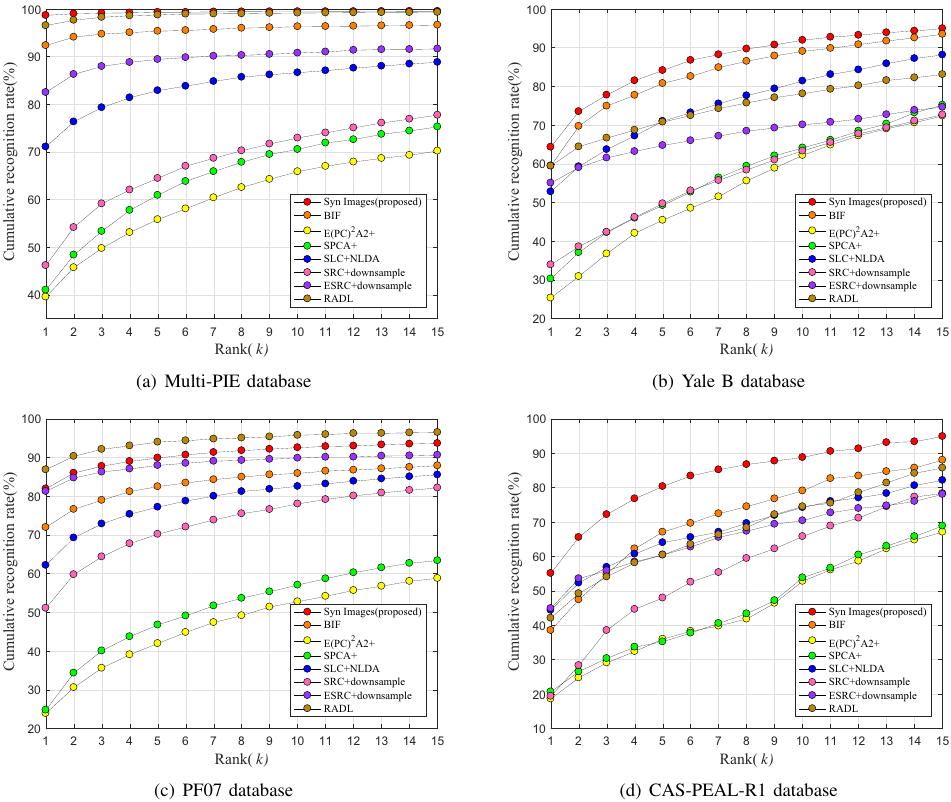
Figure 9. Face recognition rates for various databases: ( a ) Multi-PIE; ( b ) Yale B; ( c ) PF07; and ( d )